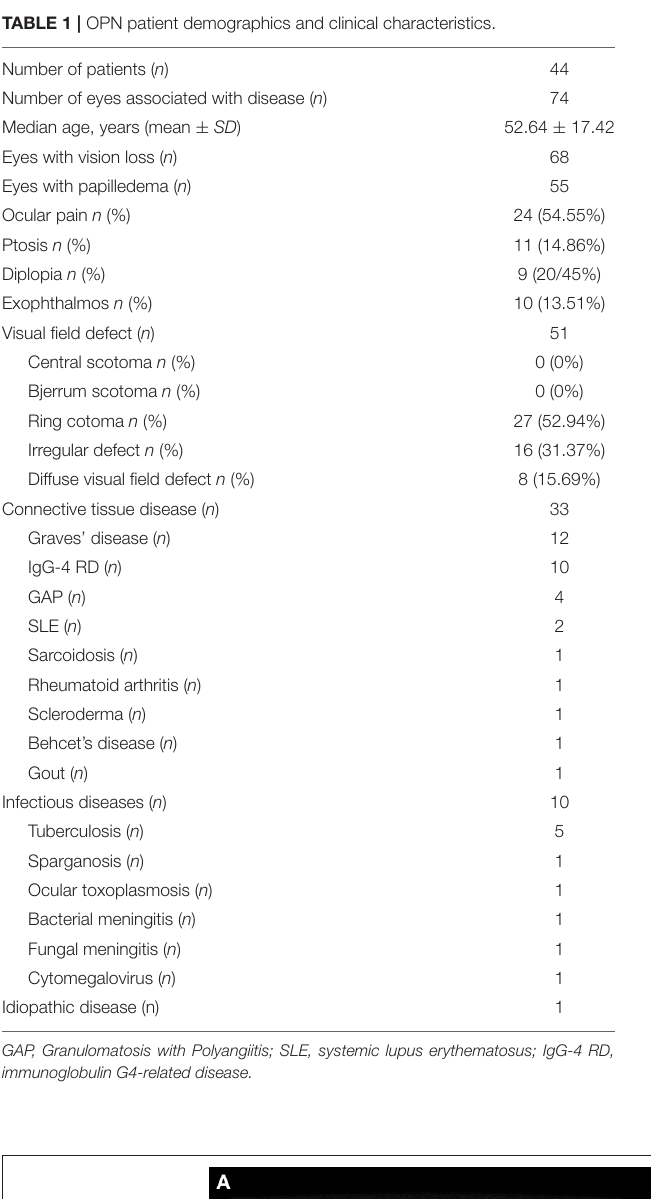
Frontiers in Neurology |